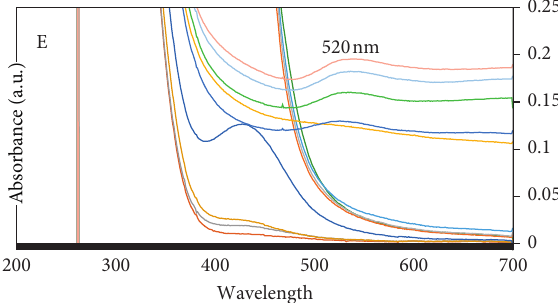
Figure 4: AgNPs at 100 ° C for 55 minutes, then addition of AuNPs at room temperature to 95 minute.